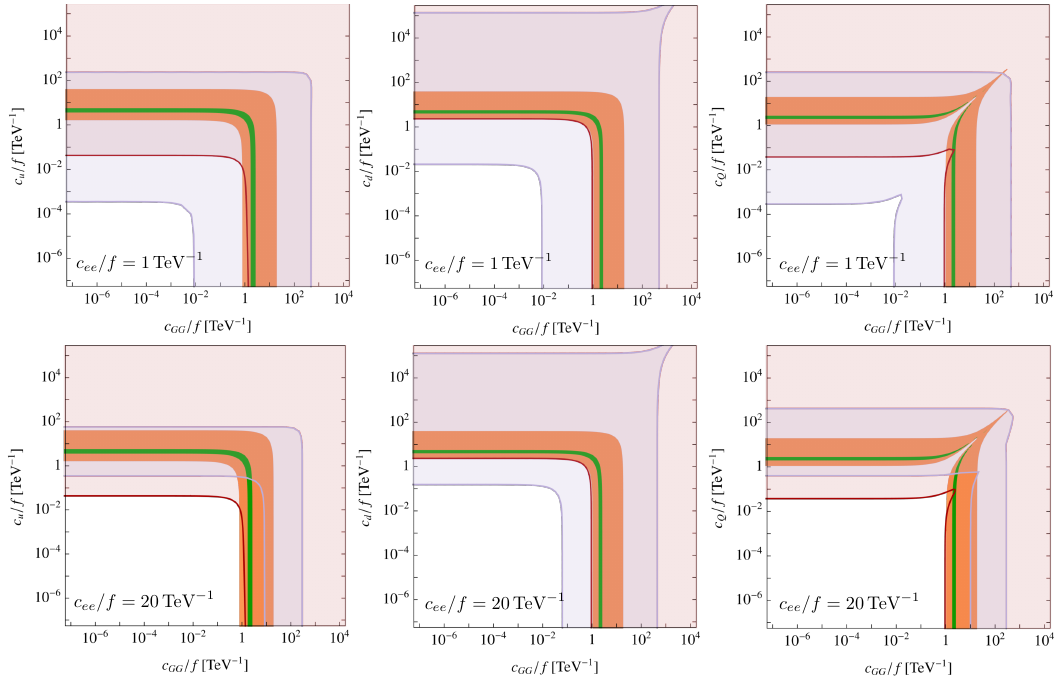
Figure 30 . Parameter space where an ALP can explain the anomalies in the Beryllium (green) and Helium (orange) nuclear transitions measured by the ATOMKI collaboration at 3 σ for different ALP- couplings to quarks (columns) and different values of the ALP-electron coupling (rows). The light purple regions are ruled out by K 0 ν ¯ ν decays [125] while the light orange regions correspond L → π to limits from K − → π − a ( e + e − ) measurements